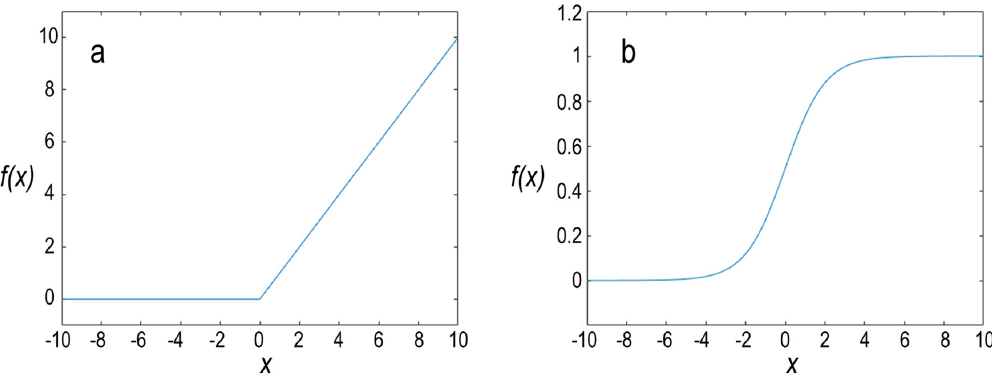
Figure 13. ( a ) ReLU function. ( b ) Sigmoid function.